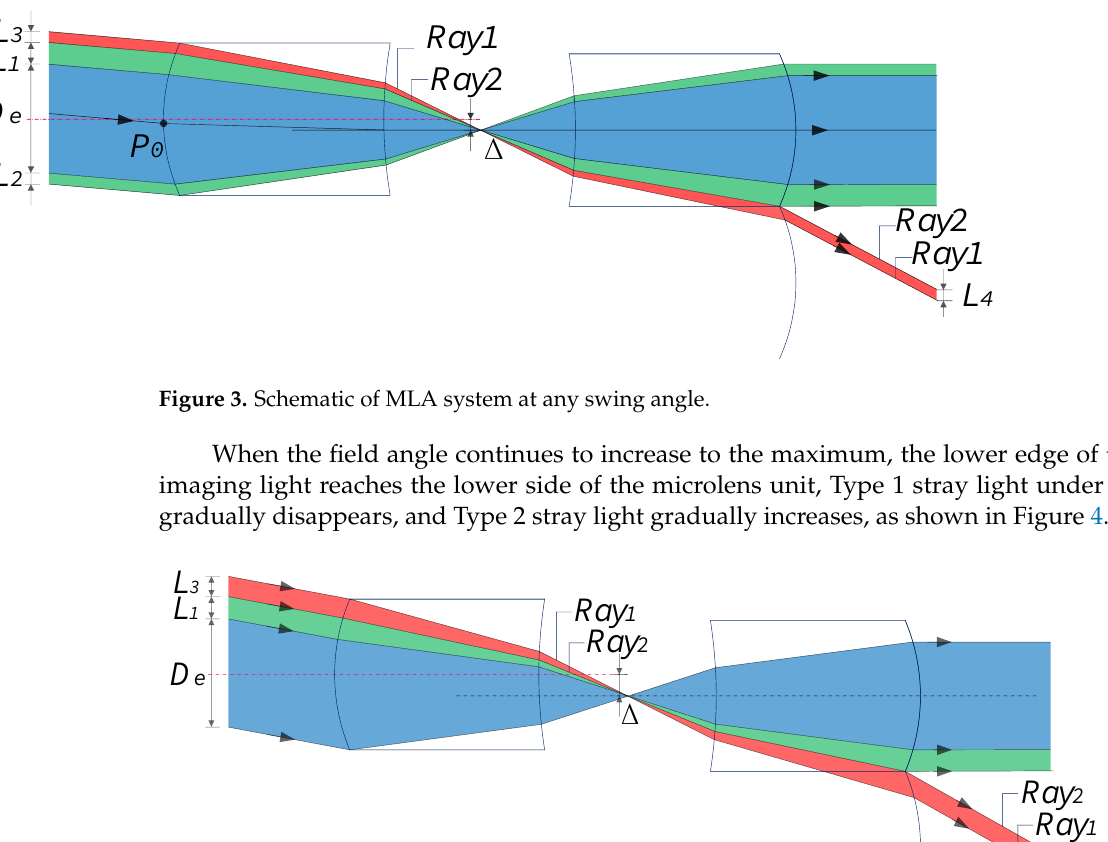
Figure 2. Schematic of zero field-of-view of a single group microlens system. The entrance pupil of the system is defined as De , which is smaller than its array lens aperture D L . When light enters the full aperture, the blue area represents the imaging light, and the green area represents the light that has still not passed the corresponding array aperture; this light in the green area is defined as Type 1 stray light. The apertures of the light line in the green area above and below De are L 1 and L 2 , respectively. When the field angle gradually increases, the displacement distance between the two positive power components of the corresponding MLA system is ∆ . The red area represents the light entering the adjacent array aperture, and its incident aperture is defined as L 3 . Normal imaging light from other units is superimposed to form an image together on the image plane, reducing the imaging quality; this is defined as Type 2 stray light. At this time, Type 1 stray light below De is relatively reduced, but it does not disappear, as shown in Figure 3.